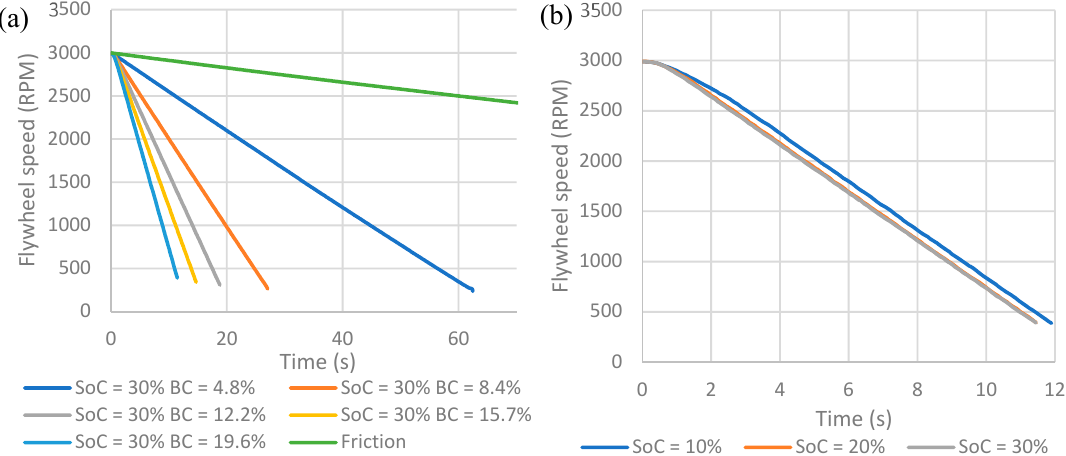
Figure 4. ( a ) Flywheel speed vs time ( b ) Flywheel speed for a brake command of 19.6% at various initial state-of-charge (SoC).